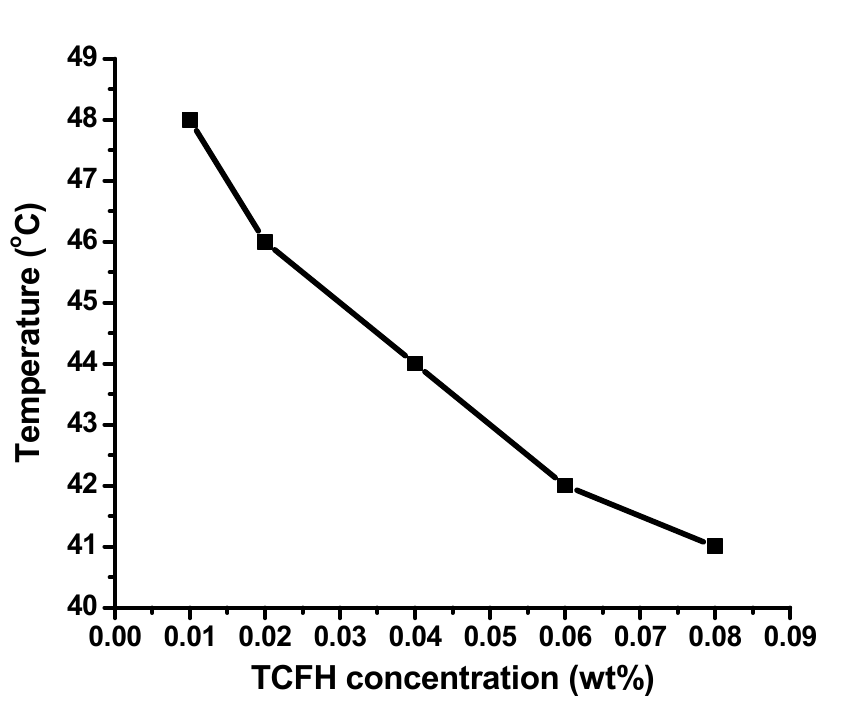
Figure 2. Melting point of urea–tricyanofuran hydrazone (UTCFH) in DMSO (pH = ~6.65) upon increasing tricyanofuran hydrazone (TCFH) concentration.